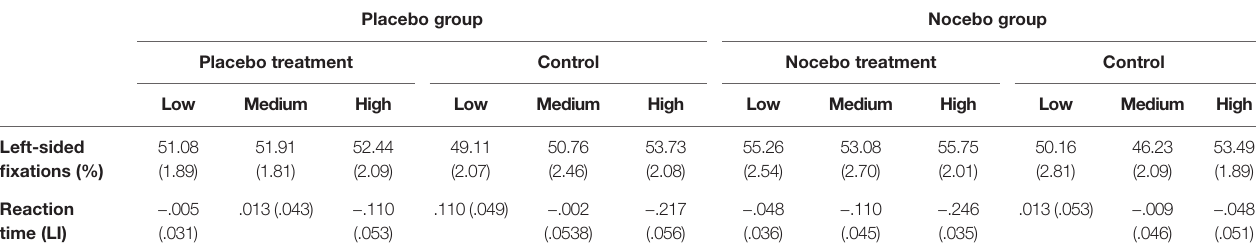
TABLE 1 | Percentages of left-sided fixations and LI reaction time (means and standard errors) in the placebo and nocebo groups (treatment minus control) for the different visual load levels. Placebo